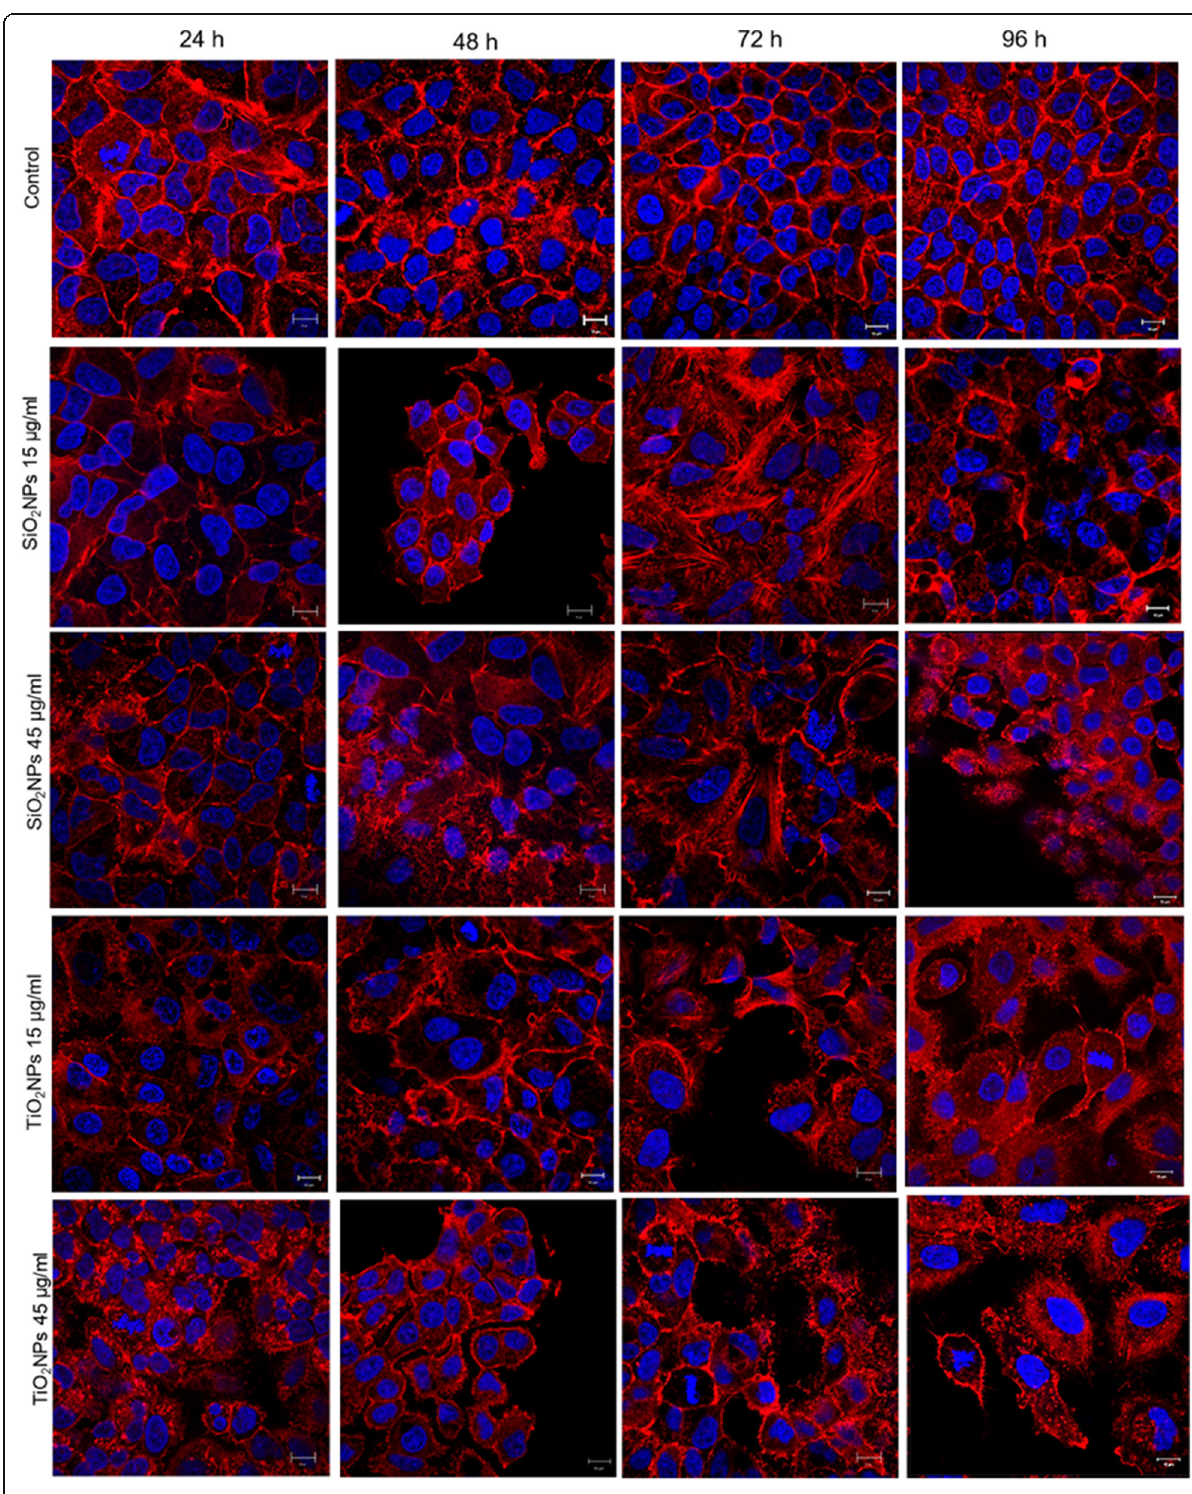
Fig. 7 Effect of SiO 2 NPS and TiO 2 NPs on actin network on A549 cells. A549 were treated with 15 μ g/ml and 45 μ g/ml of NPs for 24 h, 48 h, 72 h, and 96 h; successively they were fixed and stained with Phalloidin – ATTO 488 and DAPI. The 2D images of cortical actin were acquired by a Zeiss LSM700 (Zeiss) confocal microscope equipped with an Axio Observer Z1 (Zeiss) inverted microscope using a × 100, 1.46 numerical aperture oil immersion lens. All data were processed by ZEN software